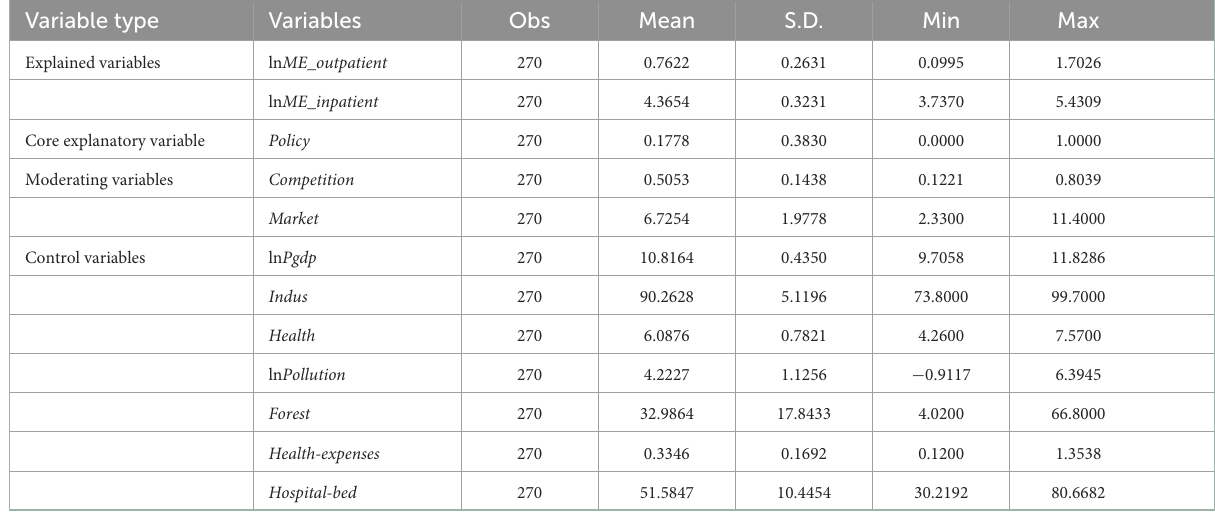
TABLE 2 Descriptive statistics.